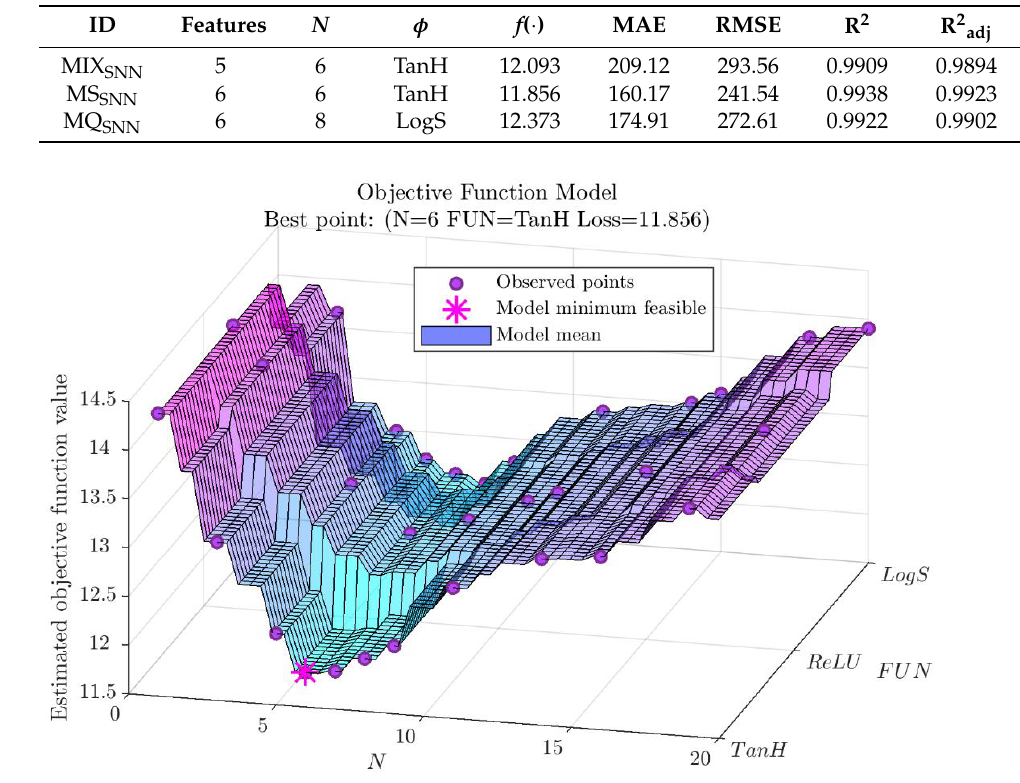
Figure 6. Gaussian Process regression model for the MS SNN .